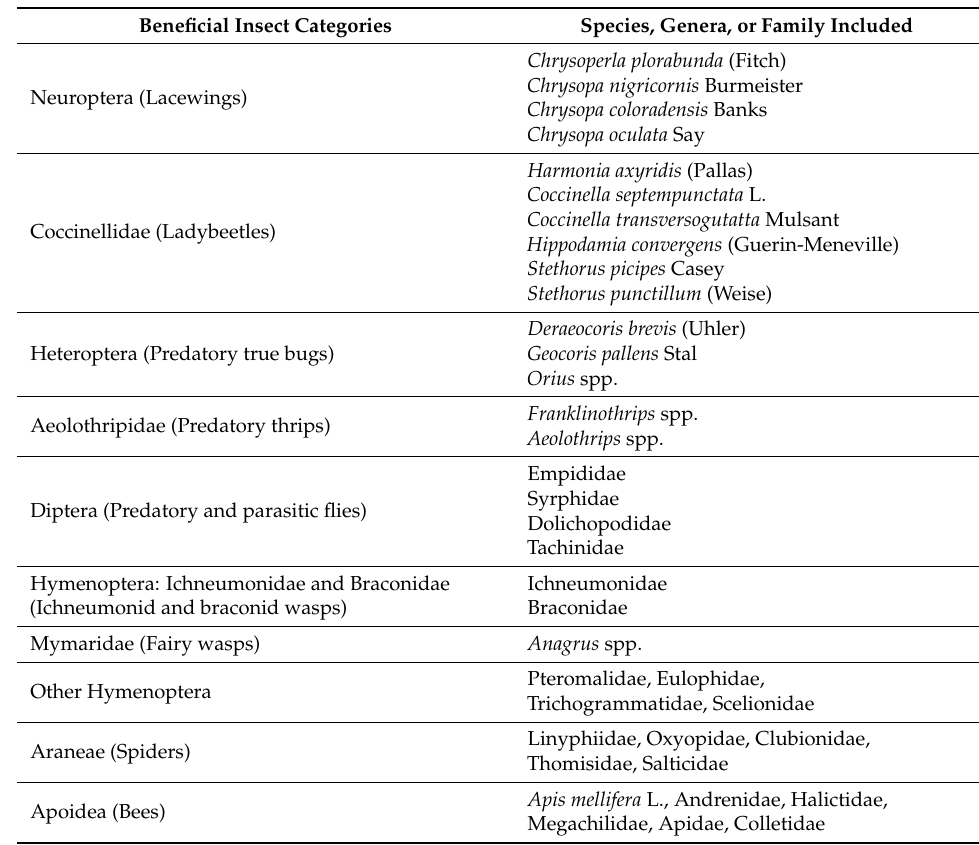
Table 1. Categories of beneficial arthropods identified and recorded in this study, along with species, genera, and families within each